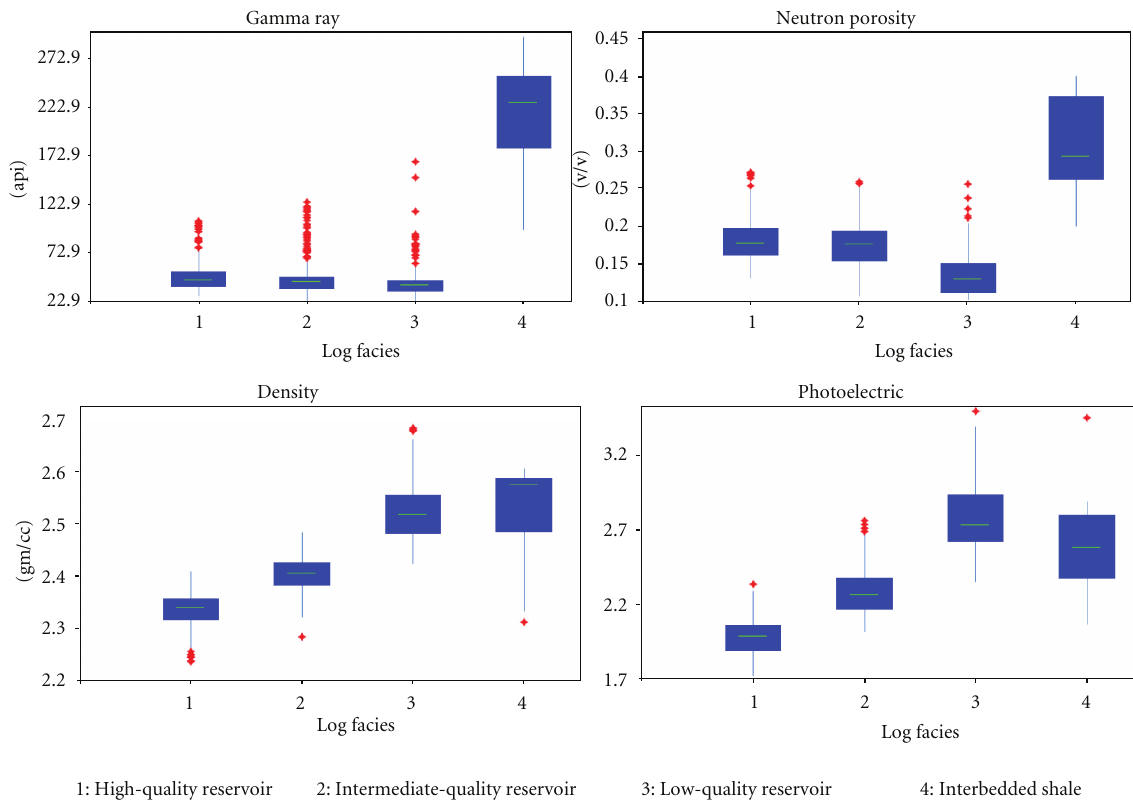
Figure 12: Box and whisker plot of the four clusters for the input logs used to generate the log facies model.